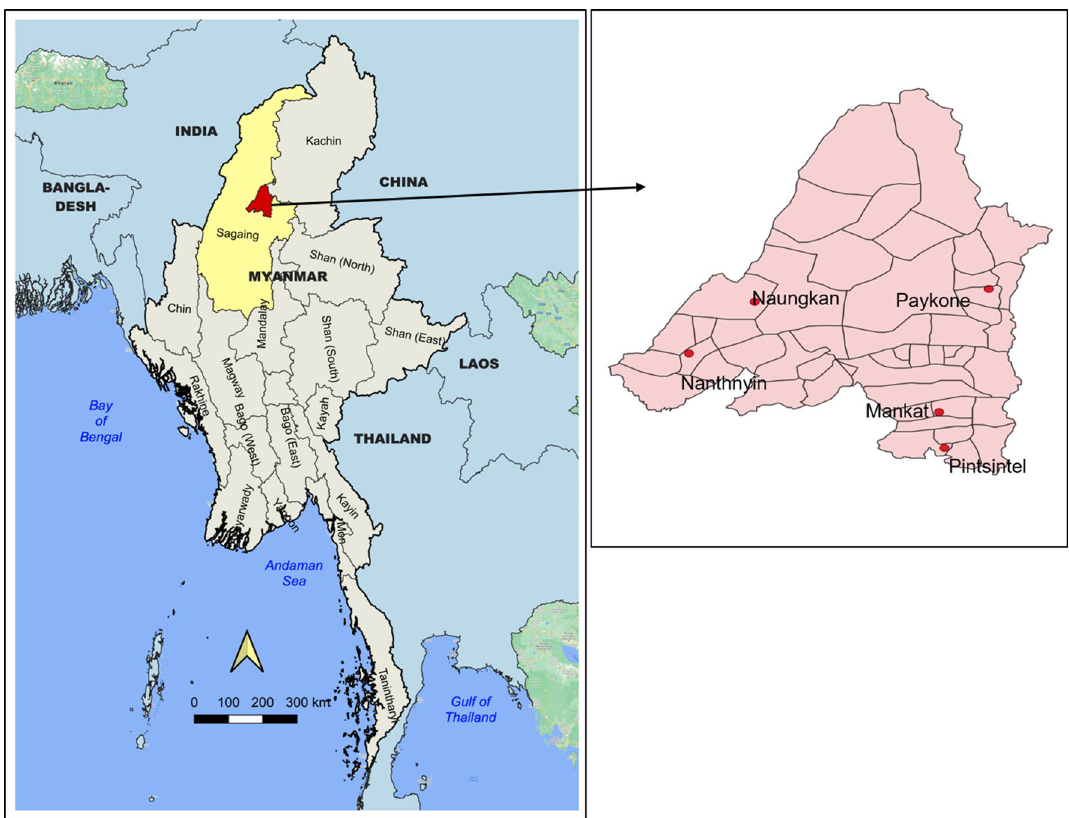
Figure 1. Location of study villages in Banmauk Township, Sagaing Region. The maps were created using Quantum GIS (QGIS) version 3.22 (https:// www. qgis. org/ en/ site/ forus ers/ downl oad.